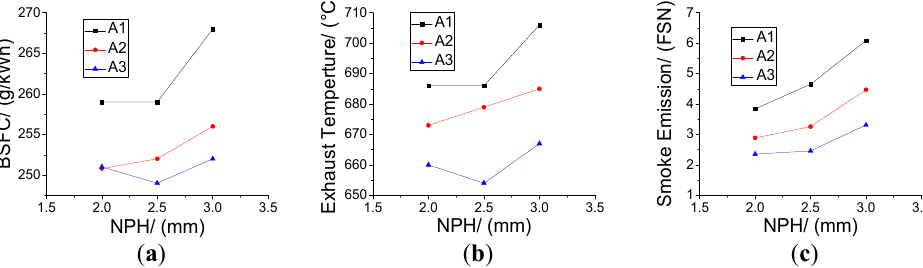
Figure 10. BSFC, exhaust temperature, smoke emission at different nozzle protrusion heights for three combustion chambers. ( a ) BSFC; ( b ) exhaust temperature; ( c ) smoke emission.